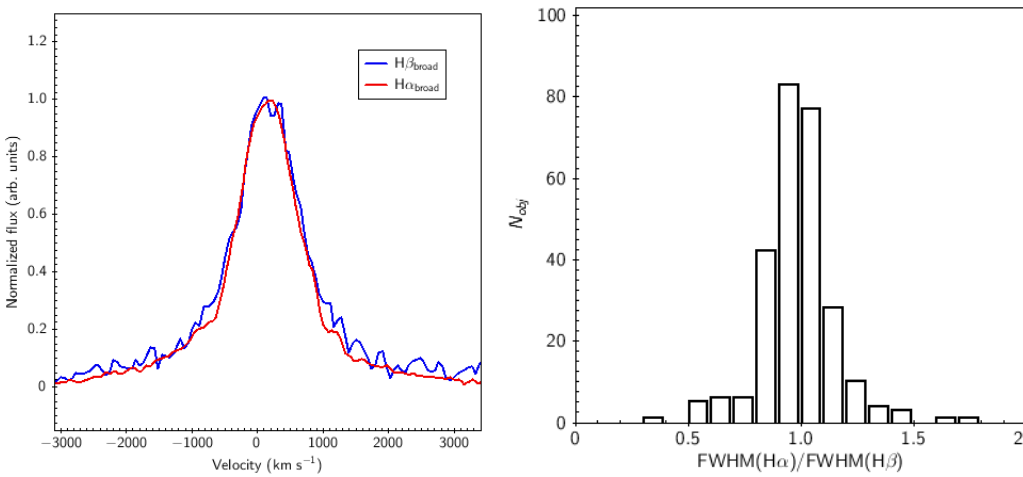
Figure 4. ( Left panel ) comparison of the H β (blue) and H α (red) broad line components, after subtraction of the narrow emission lines, plotted in velocity scale and normalized to the same peak intensity in the spectrum of 1RXS J113247.0 + 062626. ( Right panel ) distribution of the ratio FWHM(H α )/FWHM(H β ) in the broad components of the emission lines from the spectra NLS1 galaxies investigated in [18]. While the distribution is strongly peaked around 1, favoring the interpretation of an optically thin gas, some differences in the line profiles can arise as a consequence of dust absorption or emission-line radiation transfer